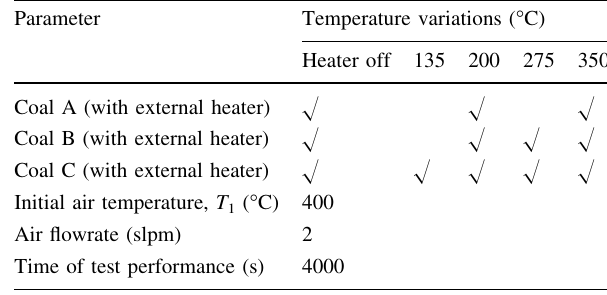
Table 3 Boundary condition of test with particle size variation